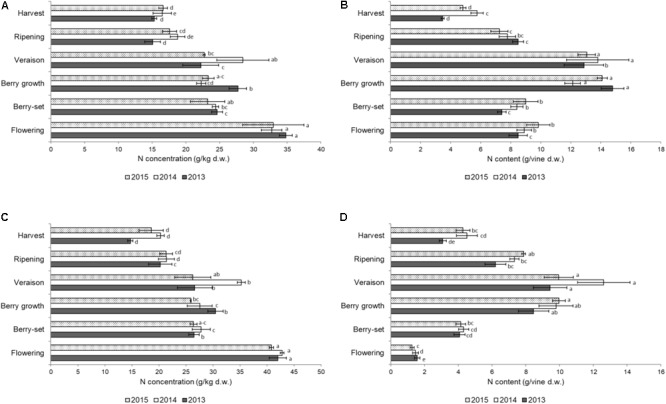
Nitrogen concentration (g/kg of dry weight) in the leaves of the primary (A) and secondary (C) shoots and nitrogen content (g per vine) in the leaves of the primary (B) and secondary (D) shoots of Italia table grape throughout the seasons of 2013, 2014, and 2015 as a function of the different phenological growth stages. Bars represent standard deviation. For each season, data points followed by a different letter are significantly different at P ≤ 0.05 according to REGQW test. Kruskal-Wallis non-parametric test was used, followed by the Conover-Iman test at P ≤ 0.05, for heteroscedastic values.